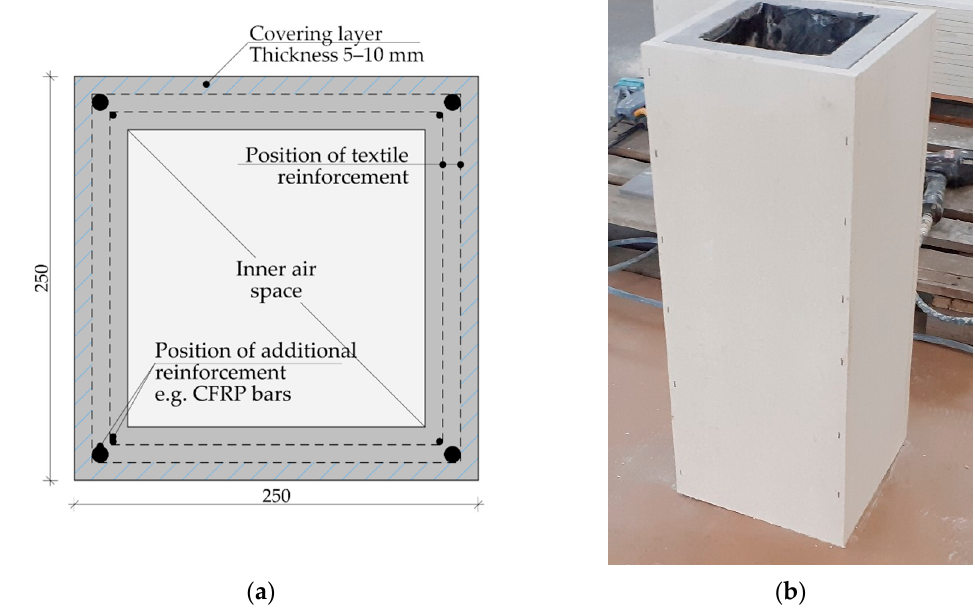
Figure 1. Scheme of the TRC beam structure (column) with hollow section 250 mm × 250 mm: ( a ) theoretical scheme of the column with additional CFRP bars reinforcement; ( b ) developed pattern of the TRC column with two layers of textile reinforcement and CFRP tensions bars covered by fire protection board system.